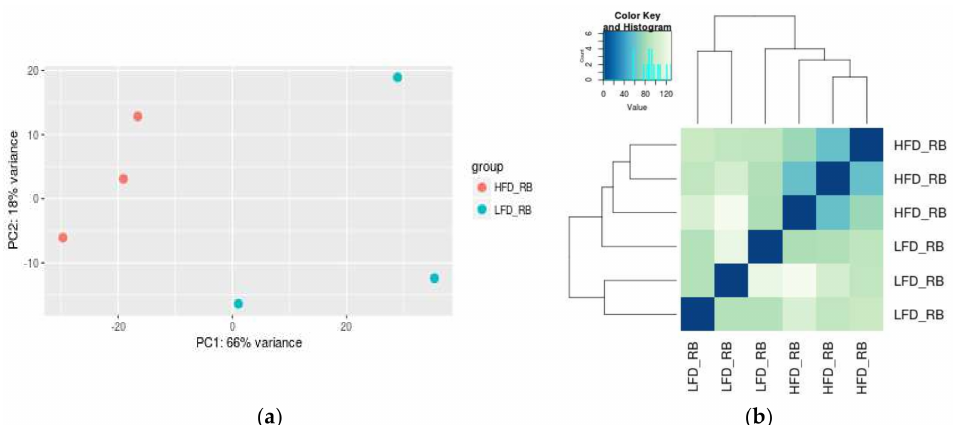
Figure 1. Clusters of the differentially expressed genes in the brown adipose tissues (BAT) of the low-fat diet (LFD)-fed lean mice and high-fat diet (HFD)-fed obese mice. ( a ) Principal component analysis (PCA) of RNA sequencing (RNA-Seq) data revealed distinct gene expression in BAT between LFD- and HFD-fed mice. Each dot represents a sequencing library and consists of normalized read counts for high quality reads. ( b ) Euclidean distance analysis showed clustering of gene expression in BAT of LFD- and HFD-fed